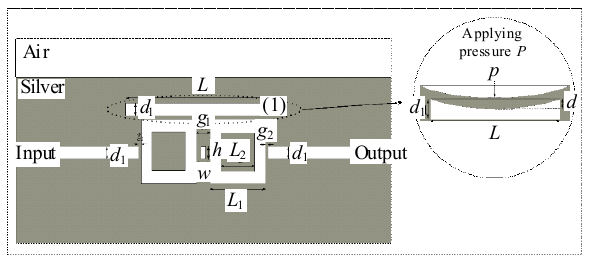
Fig. 1 Proposed device structure. The grey and white regions represent silver and air, respectively. The deformation d of waveguide (I) under pressure P is illustrated in the